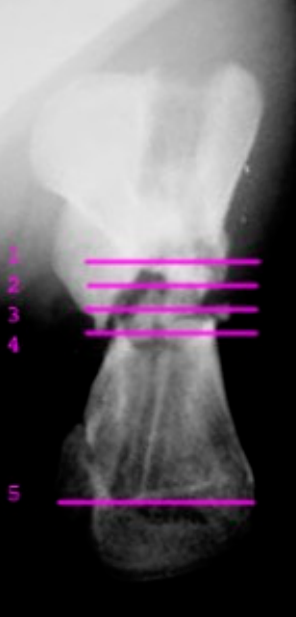
Figure 2. X-ray image of the humerus showing the levels from which the histological and morphometric findings and the microradiographs. Numbers 1 to 4 correspond to the first, second, third and fourth diaphyseal level, respectively. Number 5 corresponds to the distal epiphysis level.